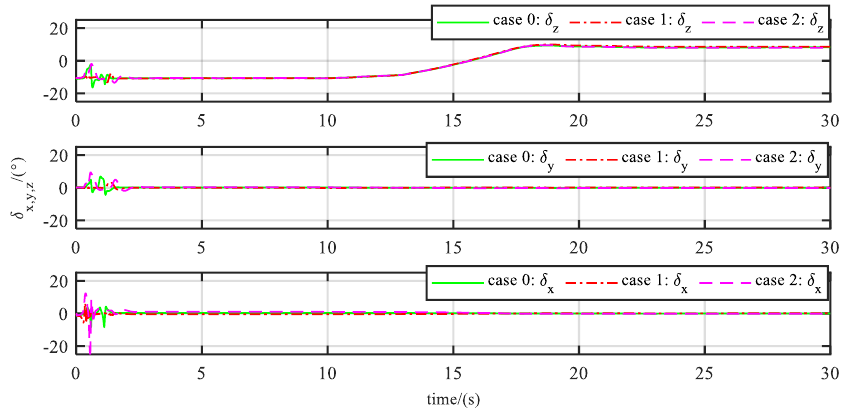
Figure 10. Control signals under three cases.